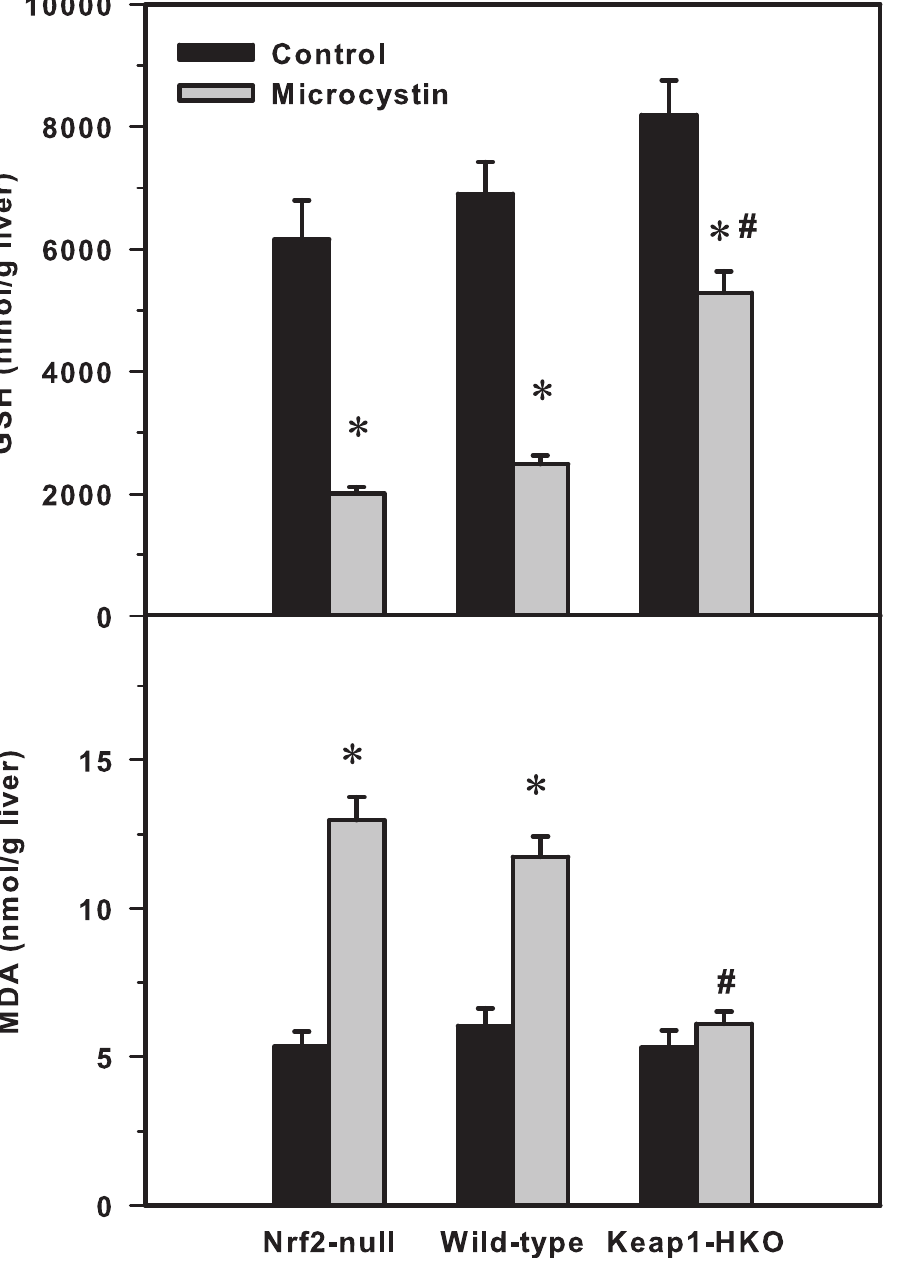
Figure 3. (Left) Hepatic glutathione concentrations (GSH), (Right) hepatic malondialdehyde (MDA) levels in Nrf2-null, wild-type and Keap1-HKO mice administered saline (10 ml/kg, i.p.) or microcystin (50 m g/kg, i.p.). Values are expressed as mean 6 S.E.M. (n=5–8). *Significantly different from the basal level of the same genotype (p # 0.05); # Significantly different from Nrf2-null mice treated with microcystin (p #